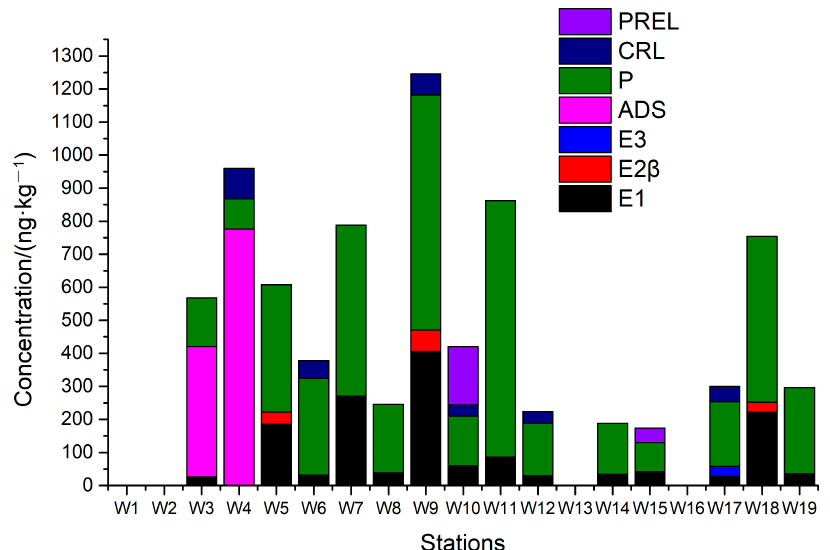
Figure 5. Distribution of steroids in sediment sampling stations